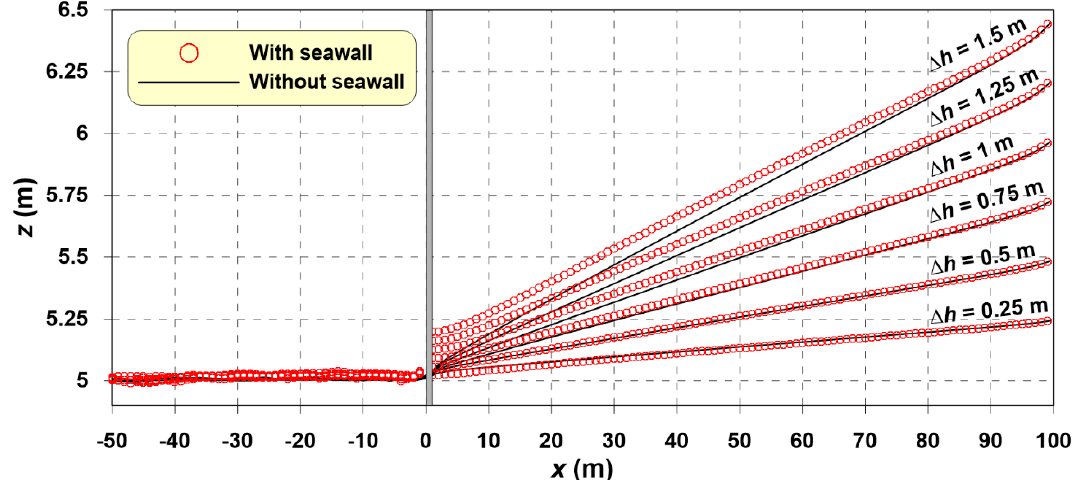
Figure 9. Groundwater table fluctuation caused by construction of a seawall in a coastal aquifer.